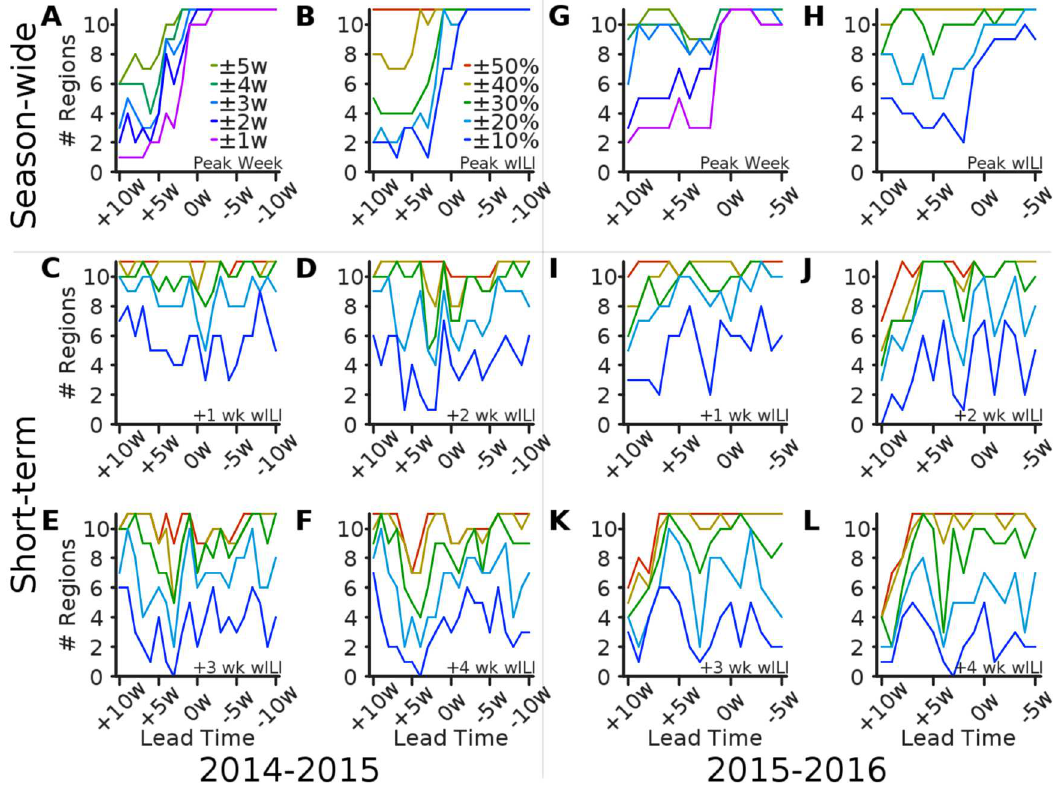
Fig 4. Number of regions accuratewithin a target range by lead time. The numberof regions where the Epicast point prediction was accurate within some range of the actual value is plotted as a function of lead time. Subplotsshow accuracy in (A; G) Peak Week, (B; H) Peak Height, and (C–F; I–L) wILI at 1, 2, 3, and 4 weeks ahead,